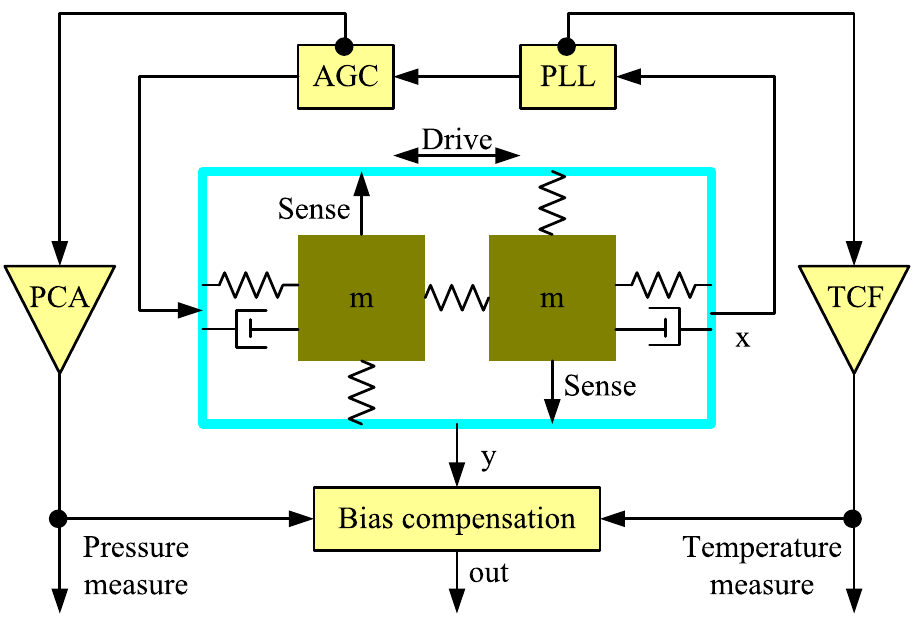
Figure 6. Signal processing for the bias